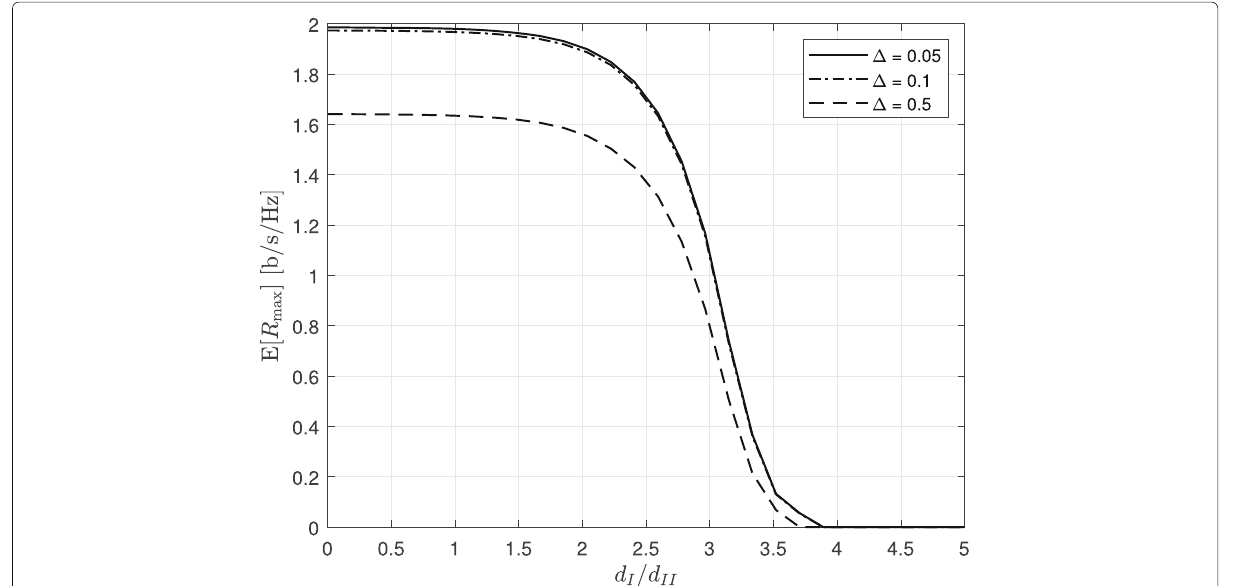
Fig. 11 Average maximum outage secrecy rate as a function of d I / d II , various values of (cid:16) , and finite-length coding ( m = 4096) with discrete (16-QAM) constellations, for d E = 10, (cid:4) = 10 − 4 , and N = 4